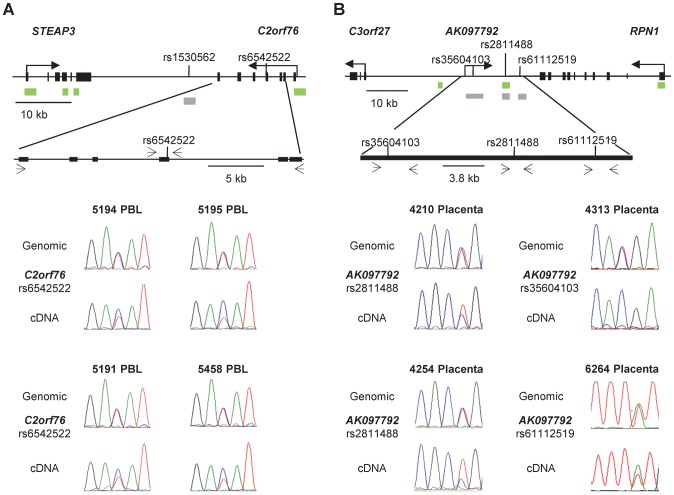
Non-imprinted ASM in the STEAP3-C2orf76 region and imprinted ASM in the RPN1-C3orf27 regions are both associated with ASE.
A, ASE of the C2orf76 gene, associated with the C2orf76-STEAP3 DMR, is shown in duplicate for four PBL samples (rs6542522). In each case the C allele is preferentially expressed in the cDNA when compared to the genomic DNA, consistent with the sequence dependent nature of ASM in this locus. Overall, 12 informative PBL samples were analyzed in duplicate for ASE and 7 PBL samples showed preferential expression of the C allele. Likewise, preferential expression of the C allele was identified in 7 out of the 22 informative liver samples (data not shown). B, ASE of the lncRNA corresponding to the AK097792 EST, overlapping the index SNP rs2811488 in the RPN1-C3orf27 intergenic DMR are shown on the left and those overlapping two additional informative SNPs, i.e. rs35604103 and rs61112519, are shown on the right for four placenta samples. Overall, the assays were performed in duplicates for 13 informative placenta samples. Ten of them showed a definite or complete ASE. In each of 6 informative samples assayed for both ASE and ASM, the hypermethylated maternal allele was the relatively repressed one.